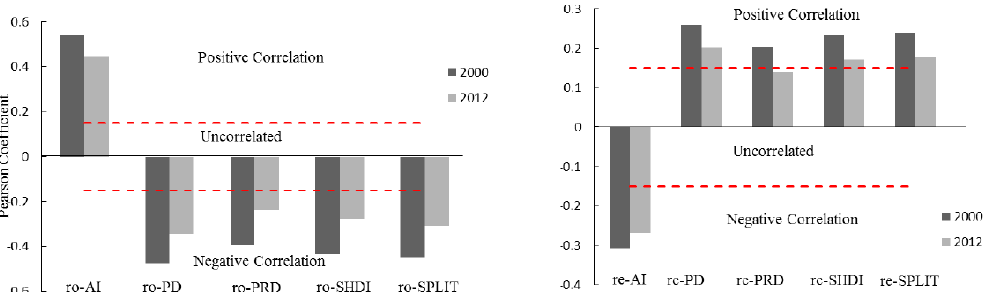
Figure 8. The correlations between landscape index and groundwater recharge (re) and surface runoff (ro) (re-AI represents the correlation between groundwater recharge and AI; and ro-AI represents the correlation between surface runoff and AI).